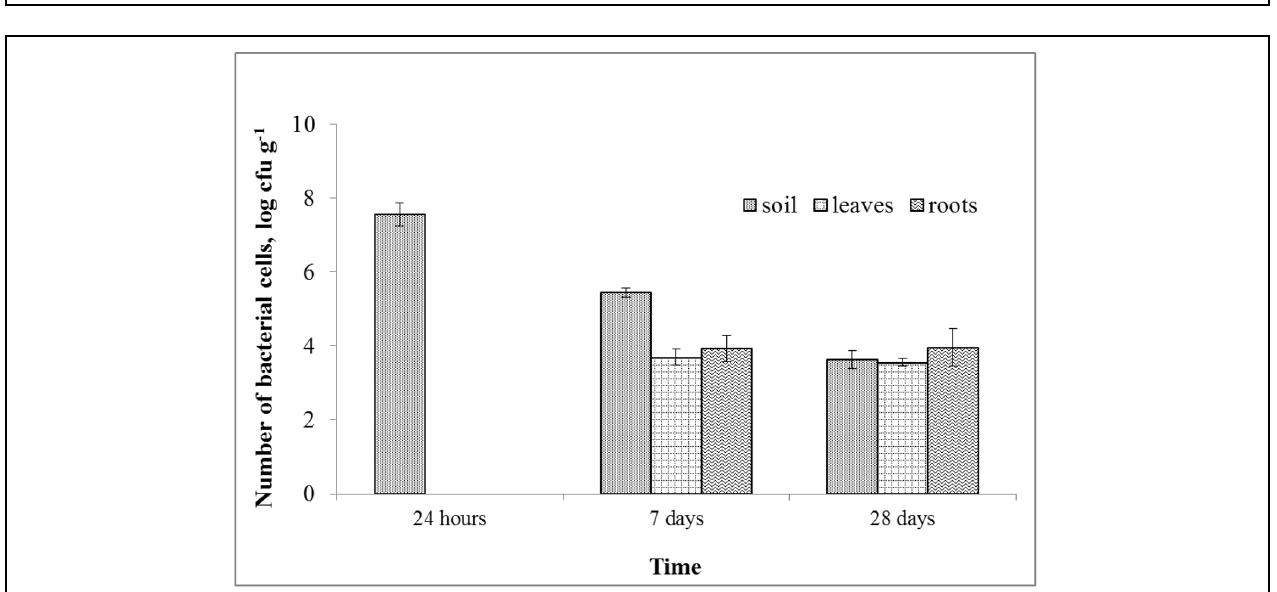
FIGURE 4 | Principal component analysis (PCA) plot of the PLFA profiles extracted from the non-inoculated control and soil inoculated with the MH8a strain. Mean of the PCA-axes values of PLFA profiles ± SD ( n = 3, p < 0.05).